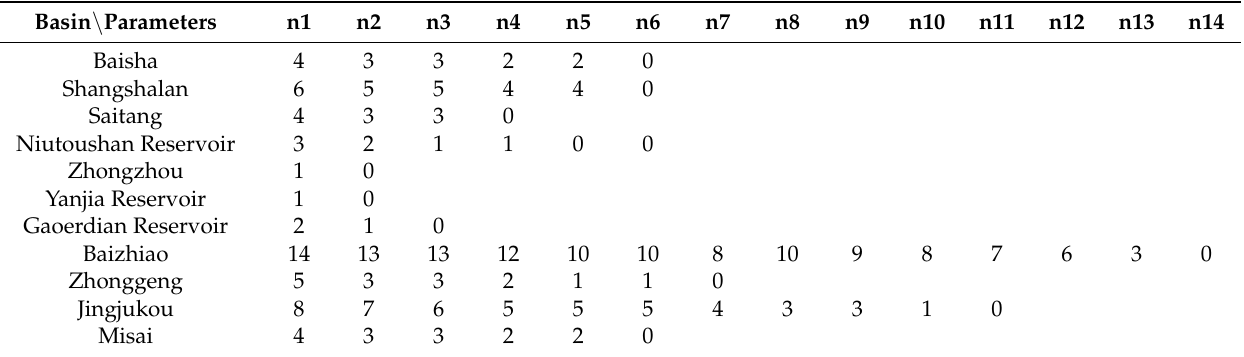
Table 8. Each sub-block n of the studied